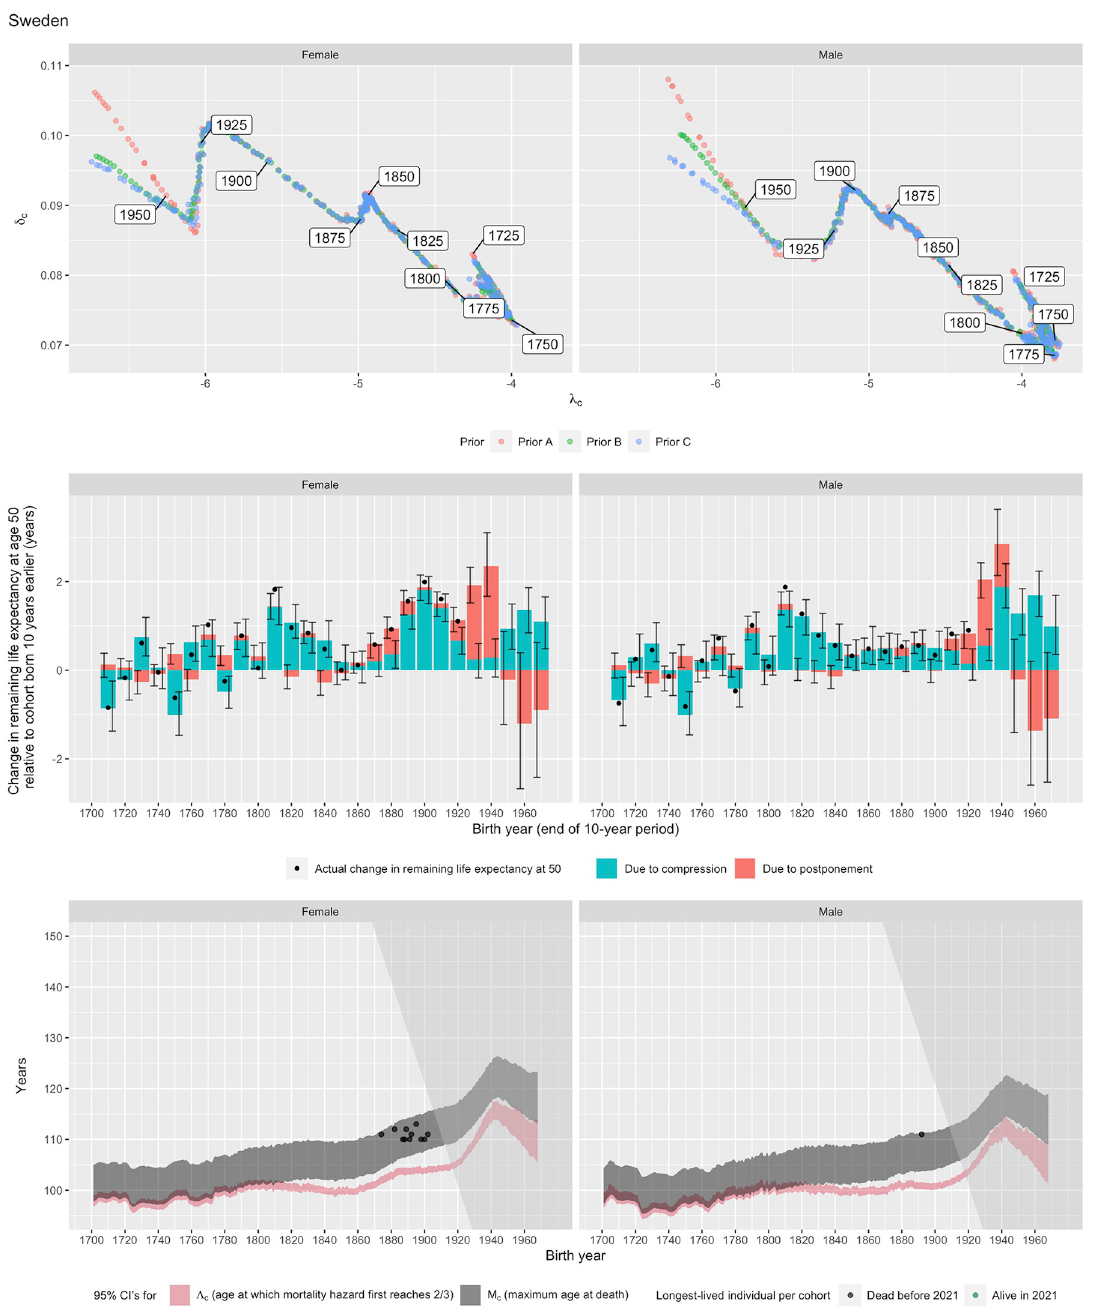
Fig 6. Bayesian estimates of slope and intercept parameters of male and female cohorts for Sweden (panel A); implied changes in remaining cohort base life expectancy at age 50 over ten year birth cohorts, divided into the portion due to postponement and portion due to compression (panel B), and 95% confidence intervals for the age at which cohort mortality hazard first reaches 2/3 ( Λ c ) and the maximum observed lifespan ( M c ) in each birth cohort (panel C). N OTE : Confidence intervals are not shown in Panel A for ease of interpretation. In the other panels, bands or bars show 95% confidence intervals for the true base value. In panel B, bar heights show median estimates. Black dots show the actual change in life expectancy for extinct cohorts. Note that under the assumption that the model is correct, this would equal the true base value plus random error due to calendar-year effects and random variation, plus the change in bias due to these. In panel C, black dots show the longest-lived person in each birth cohort from IDL [22] and GRG [23] data (green if they are still alive in 2021). The mean of M increases in line with the logarithm of cohort size at age 50 even if there are no c changes in mortality rates. The shaded area to the right of the diagonal line in panel C indicates censoring in 2021.